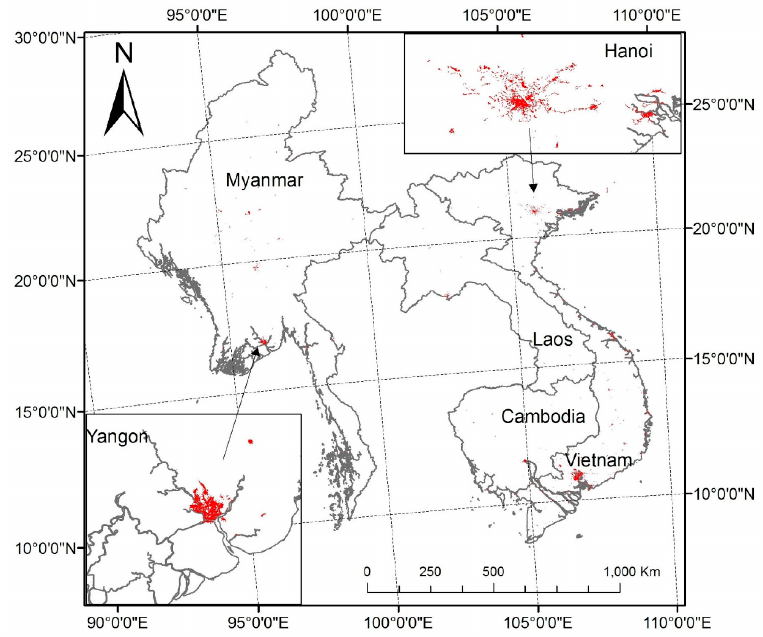
Figure 6. Urban built-up land in Vietnam, Cambodia, Laos and Myanmar in 2010 with a spatial resolution of 30 m. The area around the cities of Hanoi and Yangon are shown as examples.